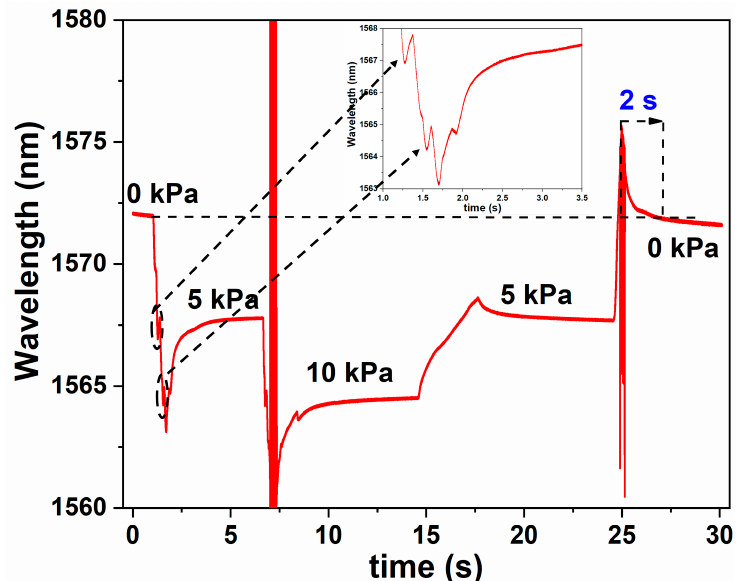
Figure 7. Response time of the probe to changes in applied gas pressure. The inset shows the expanded view of wavelength shift of the interreference minimum with increase in pressure.